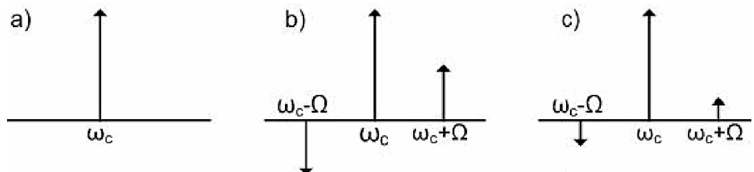
Figure 1. The spectral output of the laser at a radio frequency: ( a ) unmodulated; ( b ) modulated with no absorption; ( c ) modulated with absorption. w c and w c ± Ω represent the carrier frequency and the side band frequencies, respectively; Ω represents the frequency of the laser. Reproduced with permission from [77], the Institute of Electrical and Electronics Engineers,